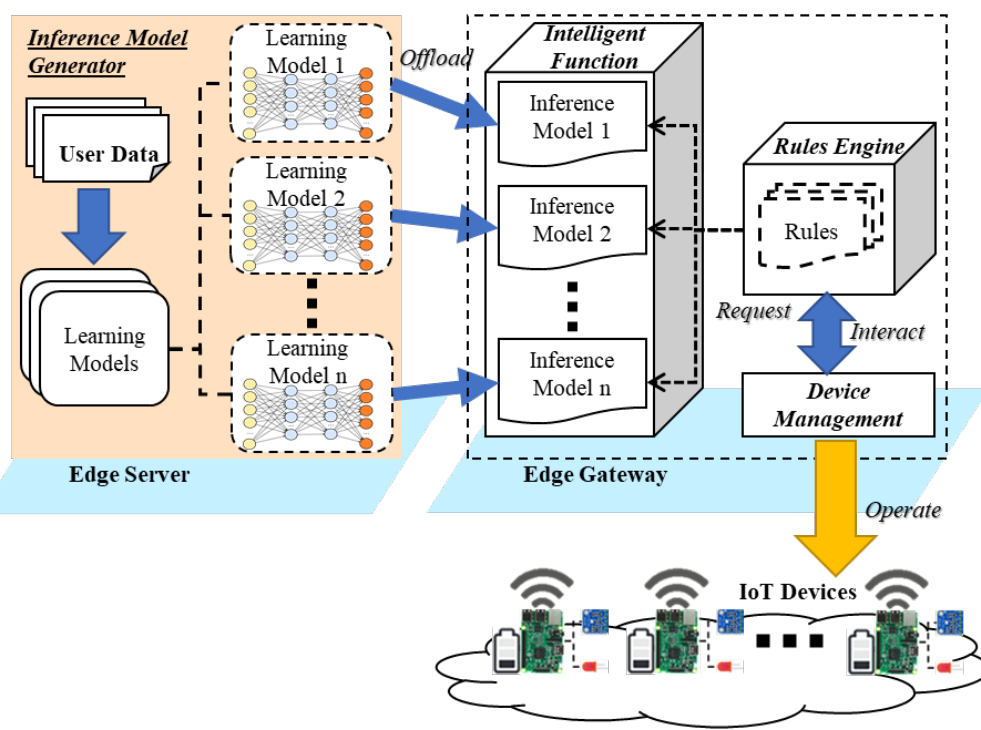
Figure 3. Offloading flow for embedding the inference model to the rule-based edge gateway.